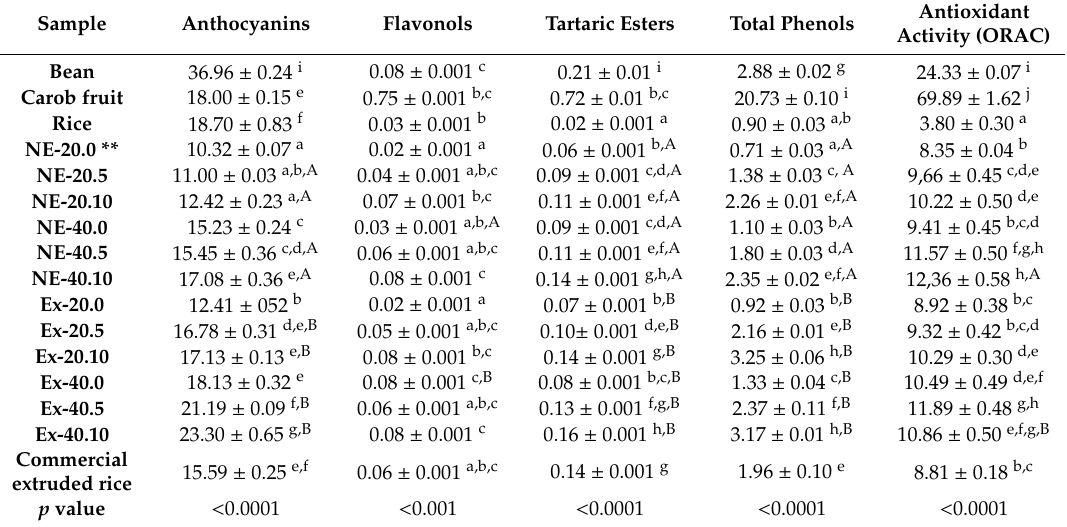
Table 4. E ff ect of extrusion on the anthocyanins ( µ g C3GlcE * / g dry weight), flavonols ( µ g QE / g dry weight), tartaric esters (mg CAE / g dry weight), and total phenols (mg ( + ) CE / g dry weight) content and antioxidant activity ( µ moles Trolox / g dry weight) of raw materials, the non-extruded (NE-) and the extruded (Ex-) flour formulations, and the commercial